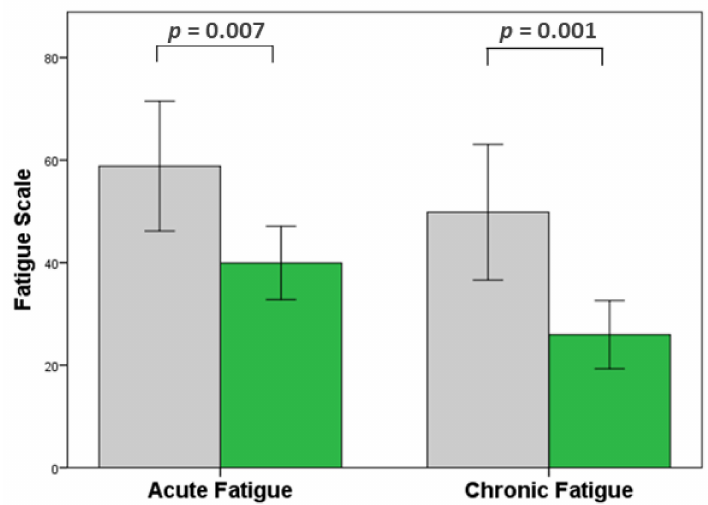
Figure 3. Acute fatigue and chronic fatigue during the Covid-19 outbreak. Drivers who visited nature at least once a week (green bars) had significantly lower acute and chronic fatigue than those who did not (grey bars). 95% confidence intervals.